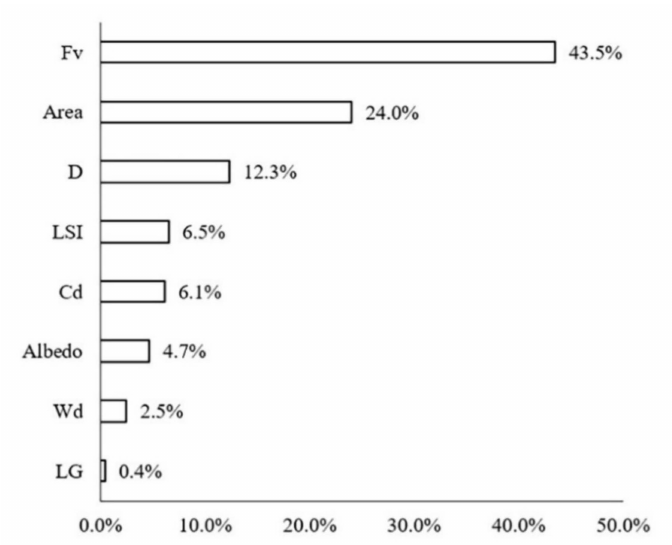
Figure 6. Contribution ratios of each spatial variable to the LST in Width-I river